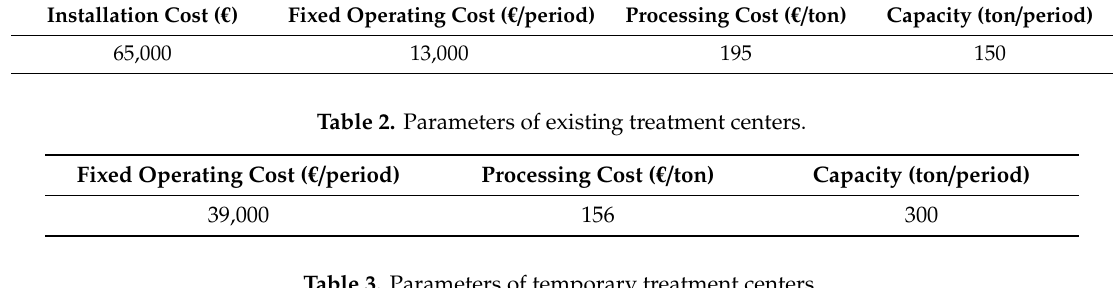
Table 3. Parameters of temporary treatment